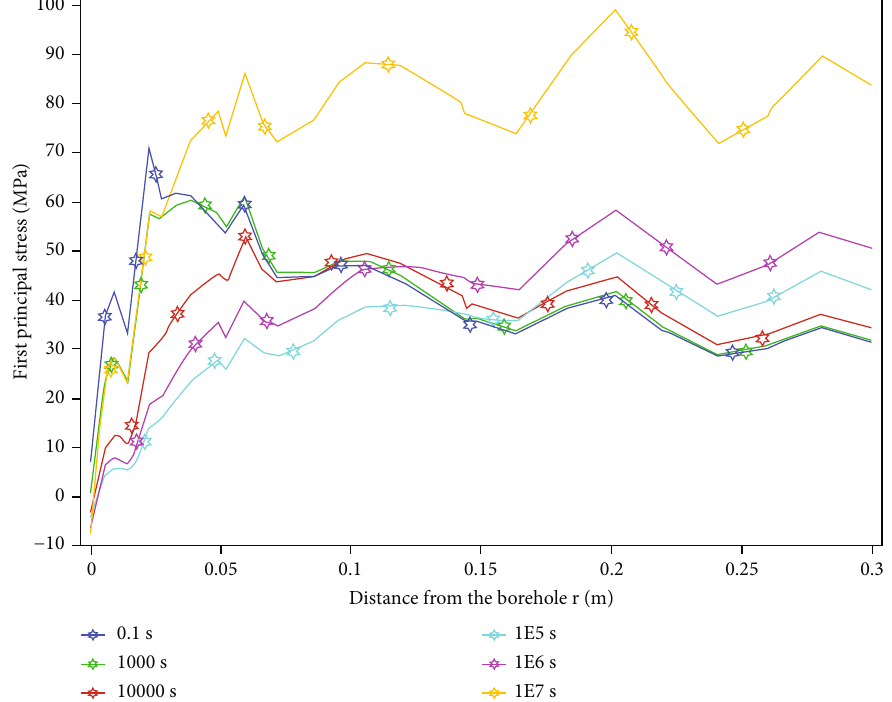
Figure 19: First principal stress in the m = 5 coal rock during CBM